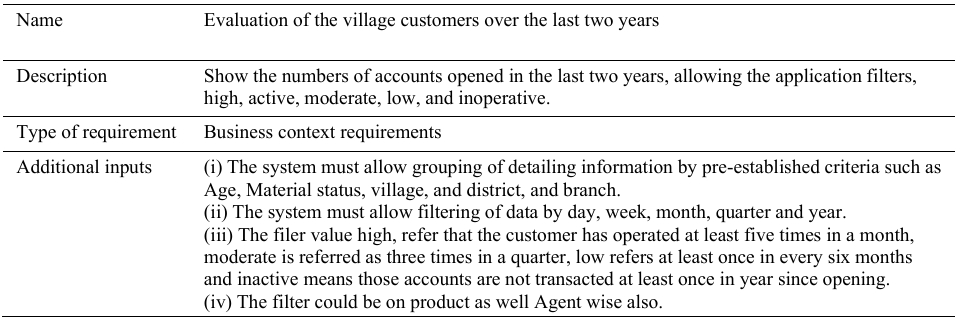
TABLE 2 O NE OF THE FUNCTIONAL REQUIREMENTS DISCOVERED IN THE ELICITATION ACTIVITY